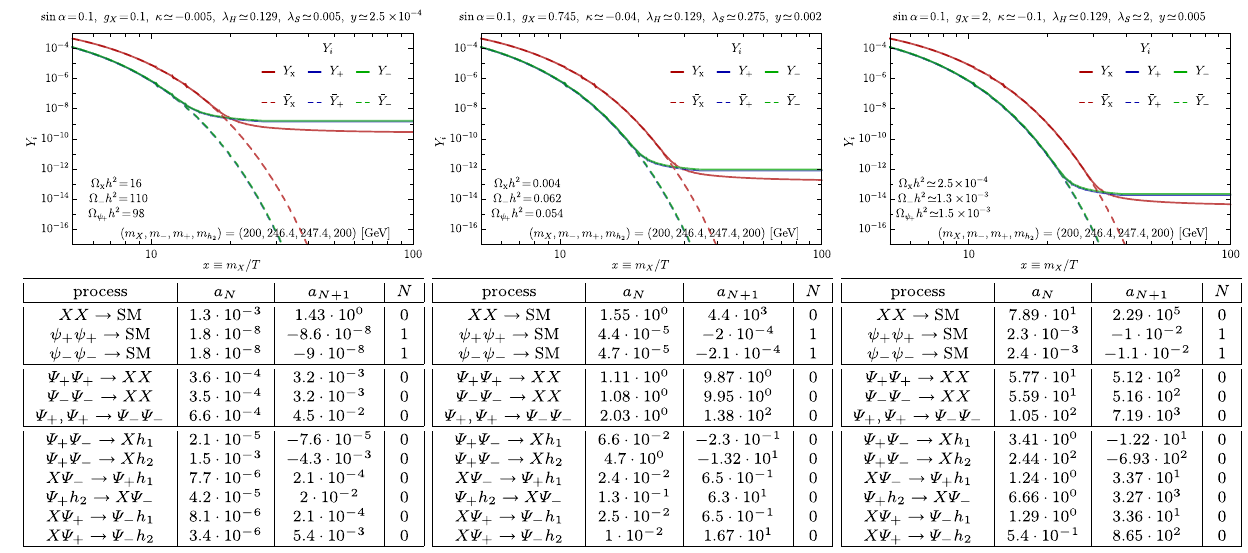
Fig. 11 Solutions of the Boltzmann equations for three sample points from the 3CDM case where all three dark states ( X ,ψ ± ) are stable are shown in the upper panels. The left, middle and right plots are for the values of parameter g x = 0 . 1 , 0 . 745 and 2, respectively. The values of other parameters (same in all the panels) are shown in the legends of plots. The tables contain first two non-vanishing coefficients